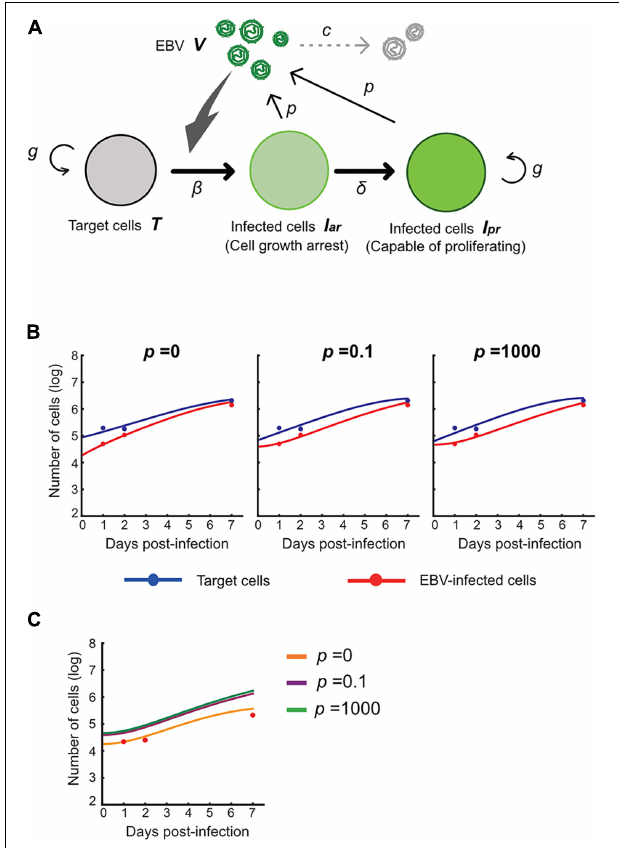
FIGURE 5 | Experimental mathematical investigation of progeny production during the pre-latent phase of EBV infection. (A) A mathematical model for EBV infection of B cells is described. The parameter g is the growth rate of cells, K is the carrying capacity, β is the cell-free infection rate, δ is the reciprocal number of the cell growth arrest period, p is the progeny virus production rate, and c is the decay rate of EBV. Note that p = 0 corresponds with no progeny virus production. (B) With fixed values of p = 0, 0.1 or 1,000, we fit Eqs (3–6) to the experimental data and describe the solid curves of the best-fit solution. (C) The number of infected cells was calculated from the mathematical model with estimated parameters. Except in the case of p = 0, prediction by the mathematical model could not property reproduce actual EBV infection dynamics properly.